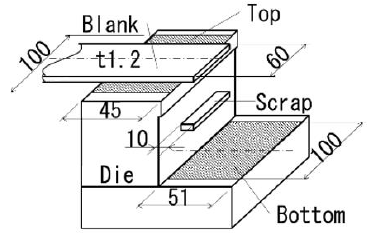
Figure 13. Conditions for measuring scattering mass of shearing slivers in continuous shearing.